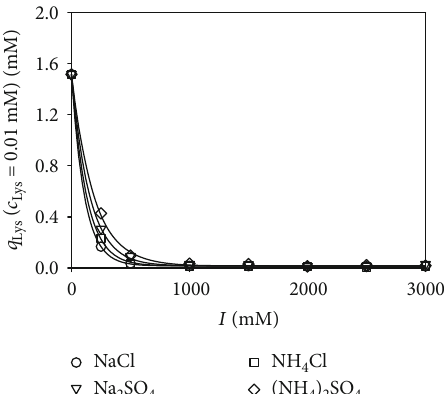
Figure 2: Experimental equilibrium adsorption isotherms (symbols) of lysozyme on Toyopearl MX-Trp-650M at pH 7.0, 25 ° C, and I = 250 mM for all studied salts and corresponding individual correlations (lines), cf. Equation (1).